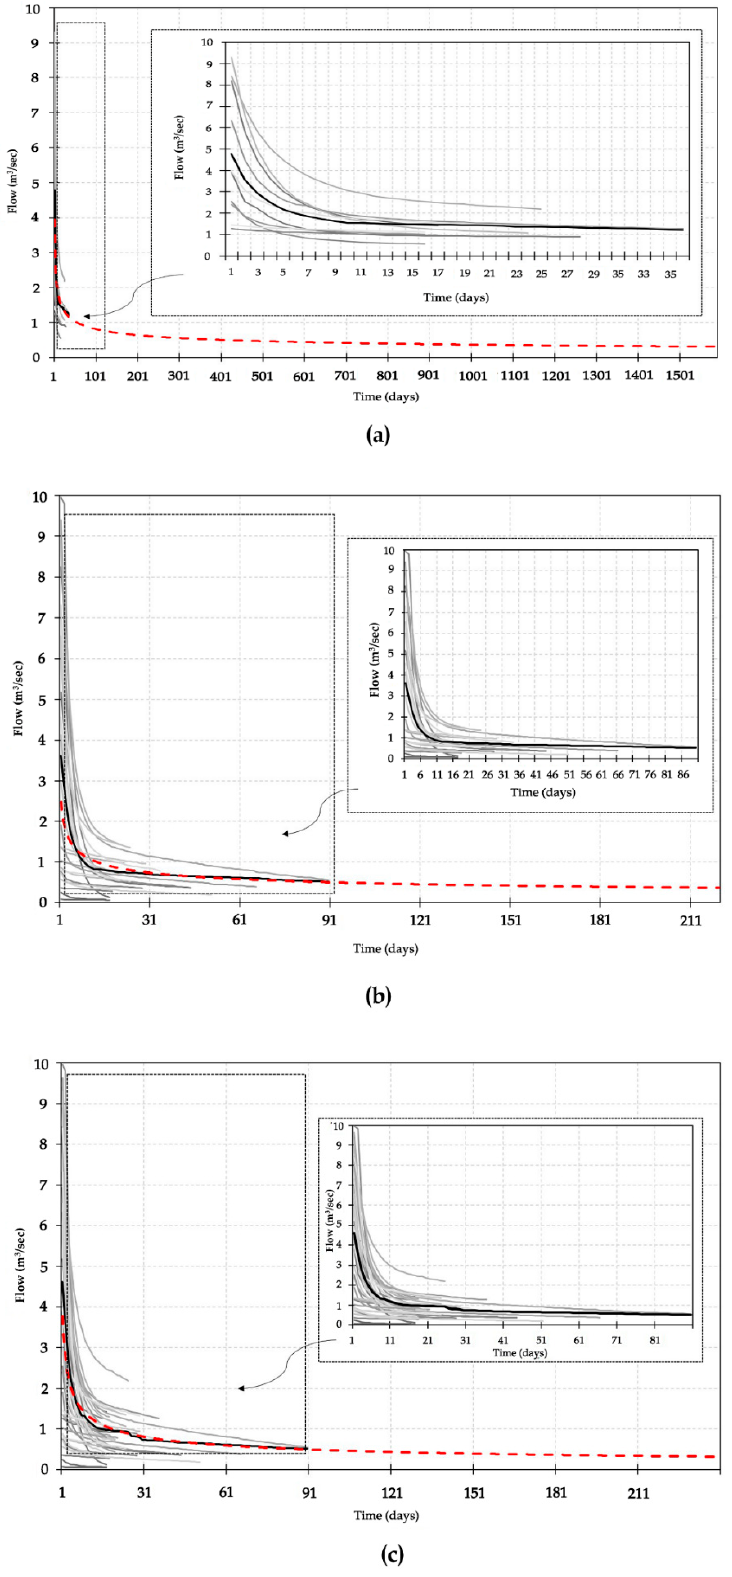
Figure 12. Results of calculating the available number of water-intake days curves: ( a ) autumn; ( b ) winter; ( c ) total period.